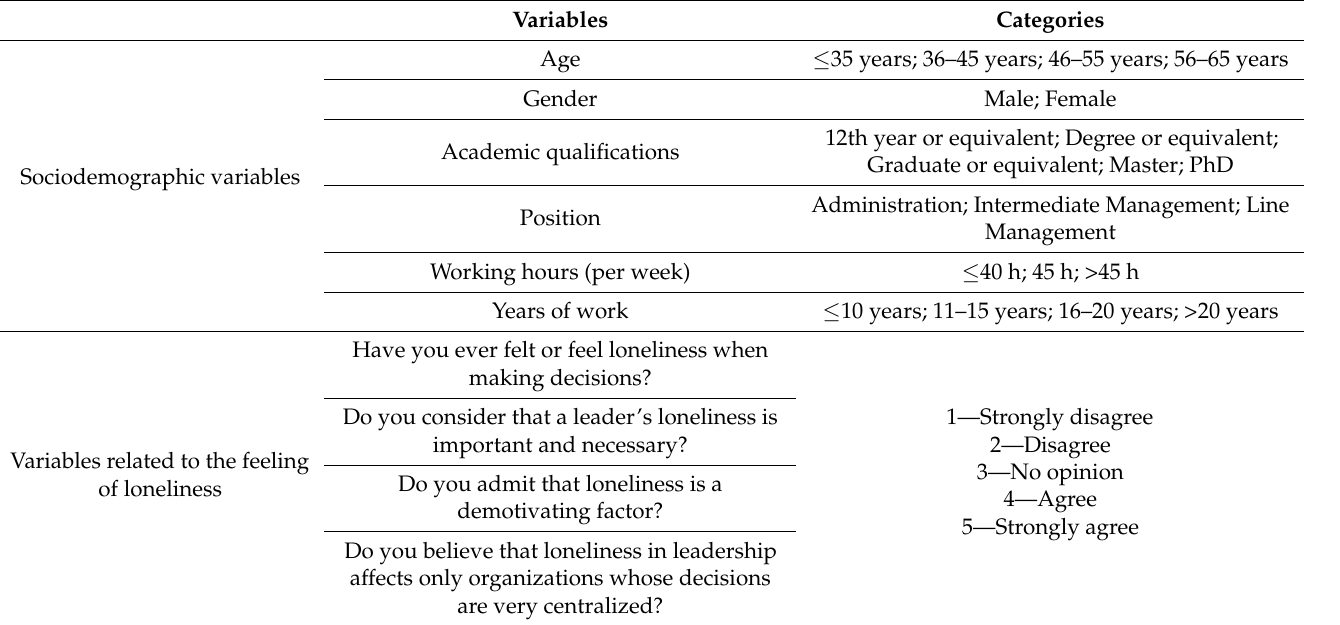
Table 1. Summary of the study